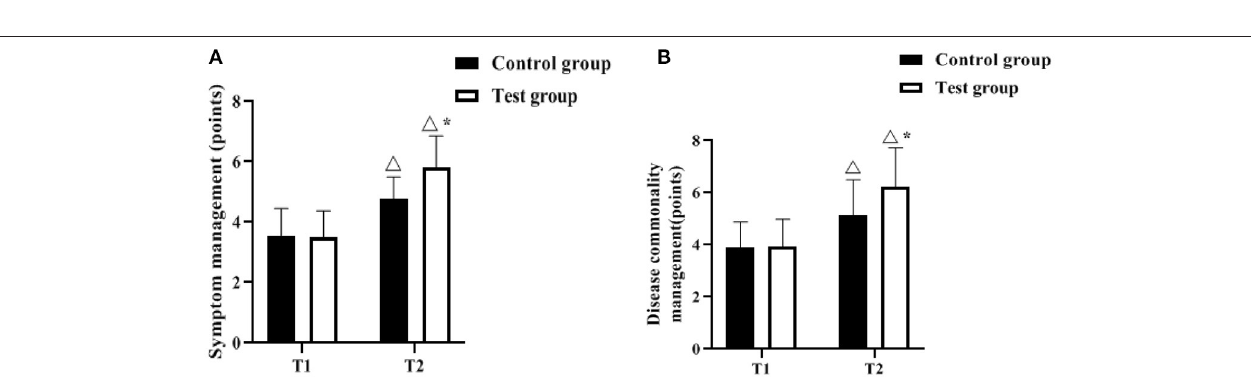
FIGURE 4 | Comparison of self-management effectiveness scores ( n , x ± s). (A,B) indicate the symptom management, disease commonality management scores, respectively. Icon 1 indicates the difference between T2 period and T1 period between the same groups, P < 0.05. Icon * indicates the difference between the two groups in T2 period, P <